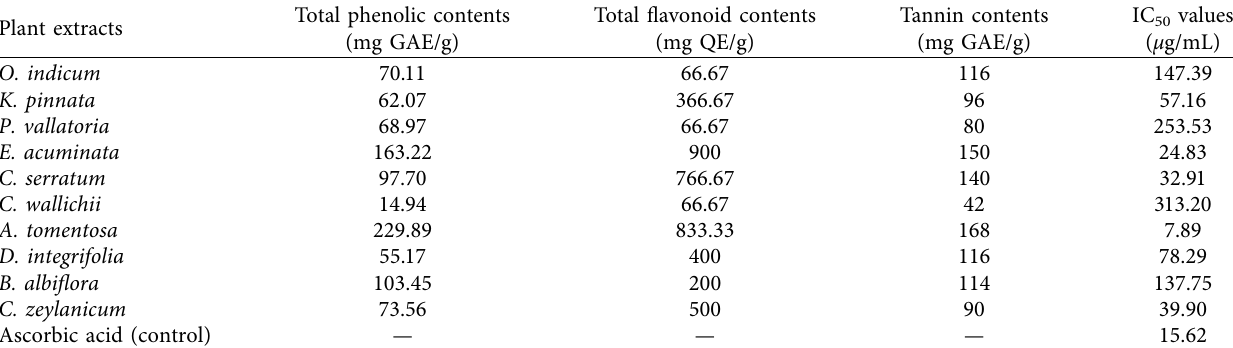
Table 4: Total phenolic contents, total favonoid contents, total tannin contents, and antioxidant activity (IC ascorbic acid).